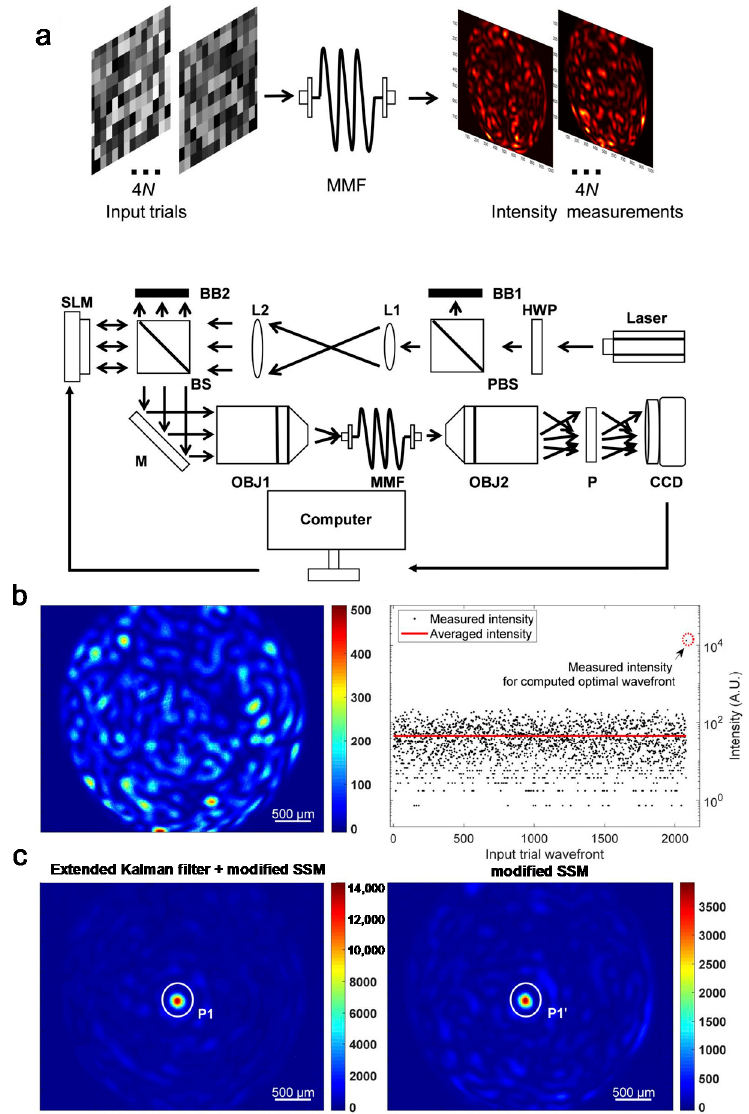
Figure 8. Calibrating the TM using modified SSM. ( a ) Schematic representation of the experimental setup. The input field is randomly modulated by an SLM and the corresponding fluctuation of the intensity is measured. BB: beam block; HWP: half wave plate; L: lens; M: mirror; MMF: multi-mode fibre; Obj: objective lens; P polarizer. ( b ) A speckle pattern transmitted through a multi-mode fibre (left) and the measured intensities at one output mode during the TM calibration process (right). ( c ) The wavefront shaping through the multi-mode fibre using the modified SSM with (left) and without (right) the extended Kalman filter. EKF: extended Kalman filter; MSSM: modified speckle-correlation scattering matrix. Adapted with permission from [52], OSA Publishing.